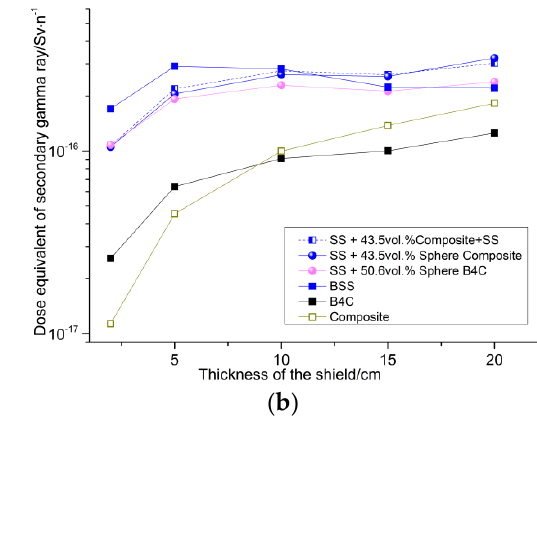
Figure 2. Flow chart of representing the structure and components of the shielding.